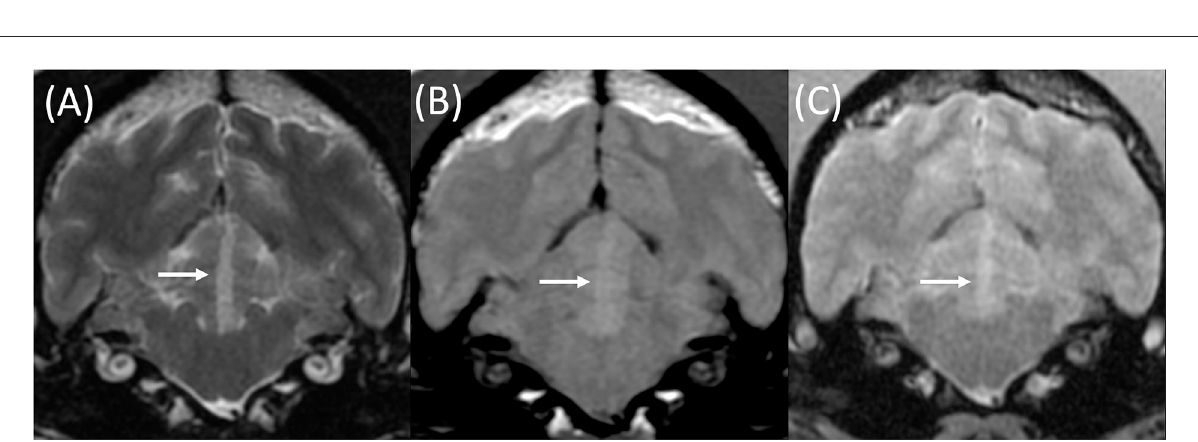
FIGURE3 Transverse T2w (A) , T1w pre-contrast (B) , and T2*w GE (C) images at the level of the rostral cerebellum in an 8-year-old female neutered Cocker Spaniel with acute onset cerebellar ataxia. The MRI was performed 3 days following the onset of clinical signs. A well-demarcated lesion is present within the left rostral cerebellum (white arrows). This is compatible with a territorial infarction of the median branch of the left rostral cerebellar artery. This lesion is homogeneously T2w (A) and T1w pre-contrast (B) hyperintense to gray and white matter, without signal void on T2*w GE sequences (C)